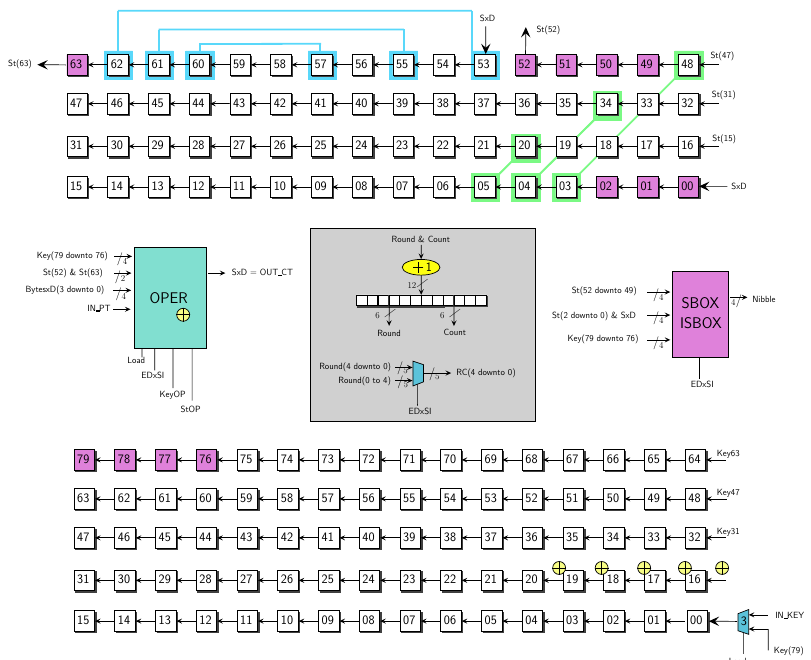
Figure 8: Combined ENC+DEC PRESENT circuit using only 6 swaps with no permutation